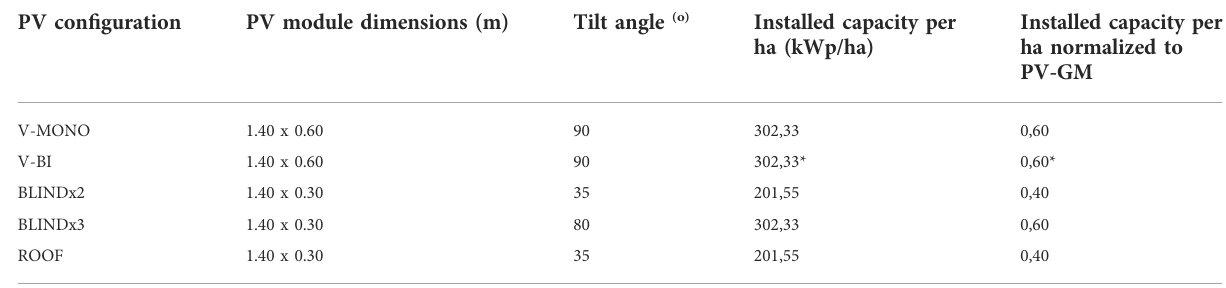
*Front side only.